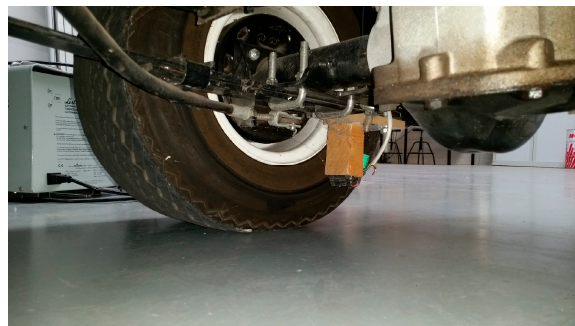
Figure 5. Range sensor used to get a real time radius measurement used to improve odometry accuracy.